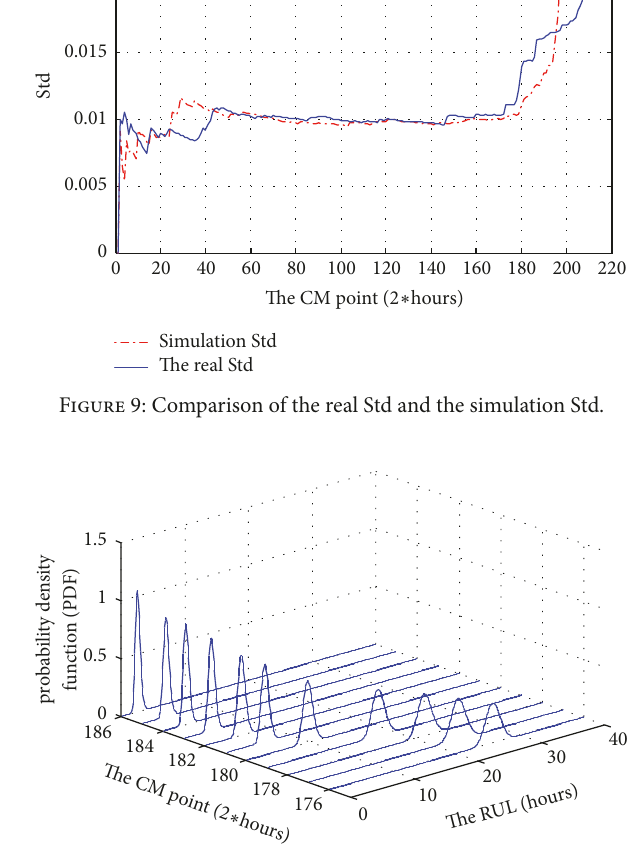
Figure 10: Illustration of the RUL distributions at last 10 CM points.